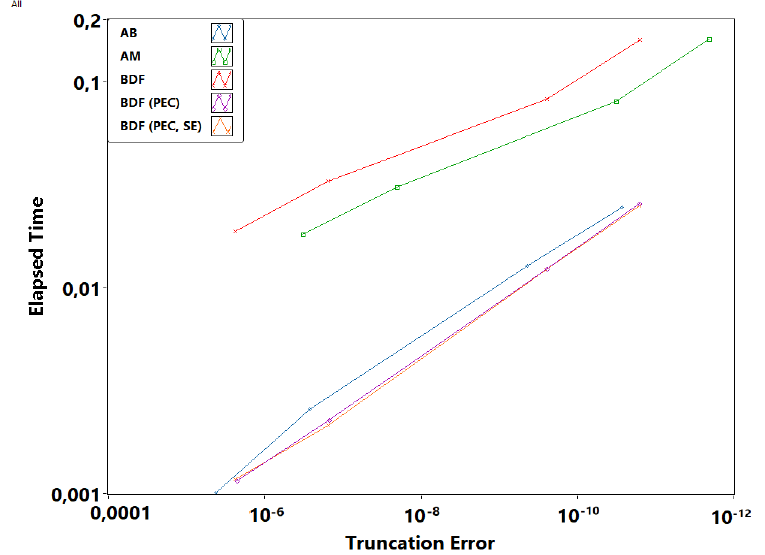
Figure 8. Comparison of the error versus elapsed time for the family of investigated methods on the Nosé–Hoover problem.